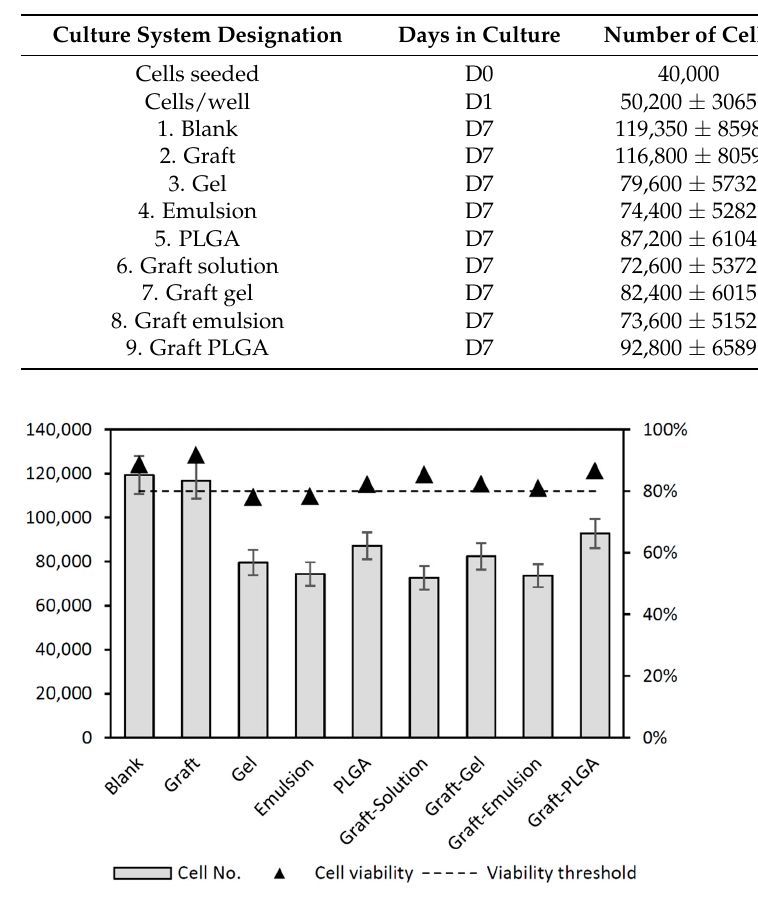
Figure 7. Effects of the formulations on cell proliferation and viability.